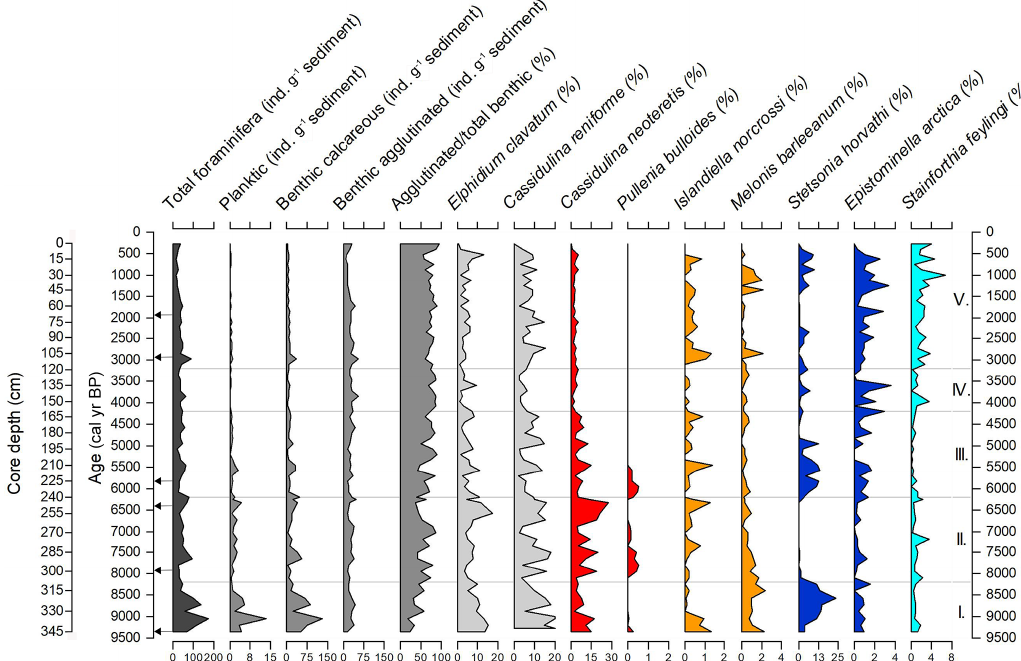
Figure 5. Foraminiferal concentrations and relative abundances of nine selected calcareous benthic species (expressed as a percentage of total benthic foraminiferal content) versus calibrated age along sediment core DA17-NG-ST7-73G. The depicted species were chosen in order to show changes in the water masses. Red represents species that indicate warm Atlantic Water inflow, orange represents species that indicate in the Arctic recirculated and chilled Atlantic Water influence, dark blue represents Arctic Water species that are commonly found in connection to Polar Water and often live beneath perennial or near-perennial sea ice, and light blue represents a species that indicates sea ice edge conditions. Ecozones (I–V) are shown on the right side of the figure. Black arrows next to the left primary y axis (age) mark radiocarbon dates. Note that the x axes have different